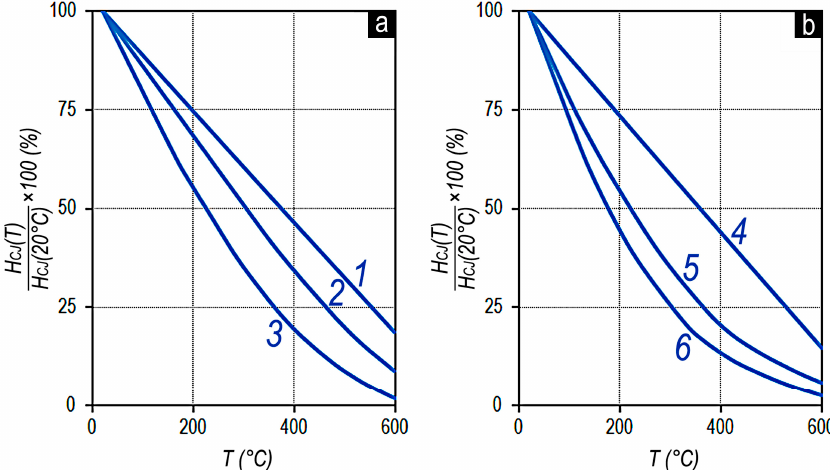
Figure 9. Temperature dependences of the intrinsic coercive force (H CJ (T)) of the Sm 1-X Zr X (Co 0.702 Cu 0.088 Fe 0.210 ) Z alloys with x = 0.15 ( a ) and z = 6.l (1); 6.3 (2); 6.6 (3), and x = 0.19 ( b ) and z = 6.0 (4); 6.4 (5); 6.7 (6); values are reduced to H CJ at 20 ° С .